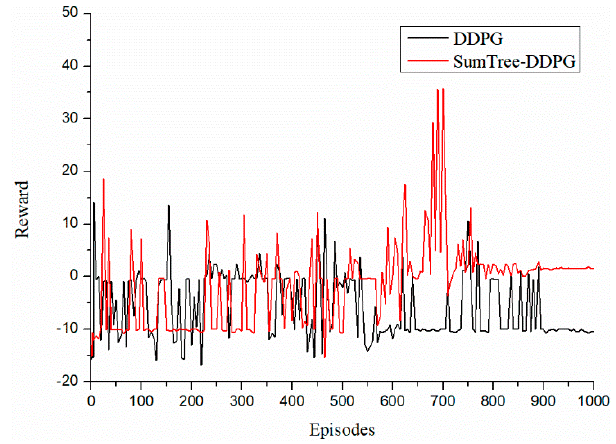
Figure 14. Total reward per episode of AUV training in Environment 2.